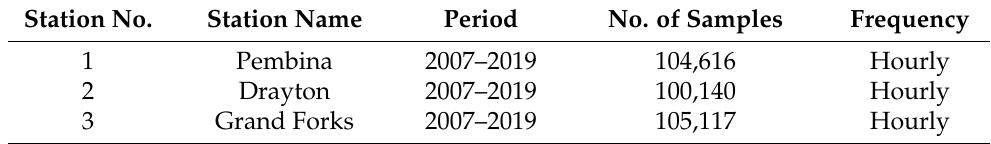
Table 1. Characteristics of the water-level time series at three hydrology stations of the Red River. Station